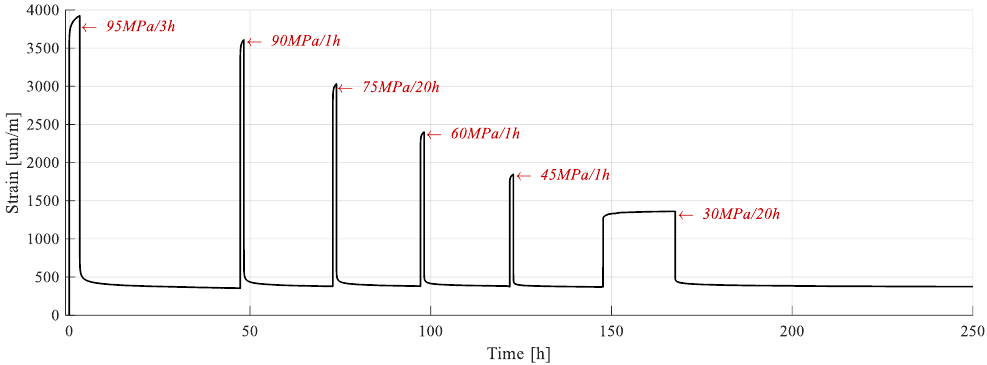
Figure 13. Deformation response during a creep-recovery test on a conditioned sample.